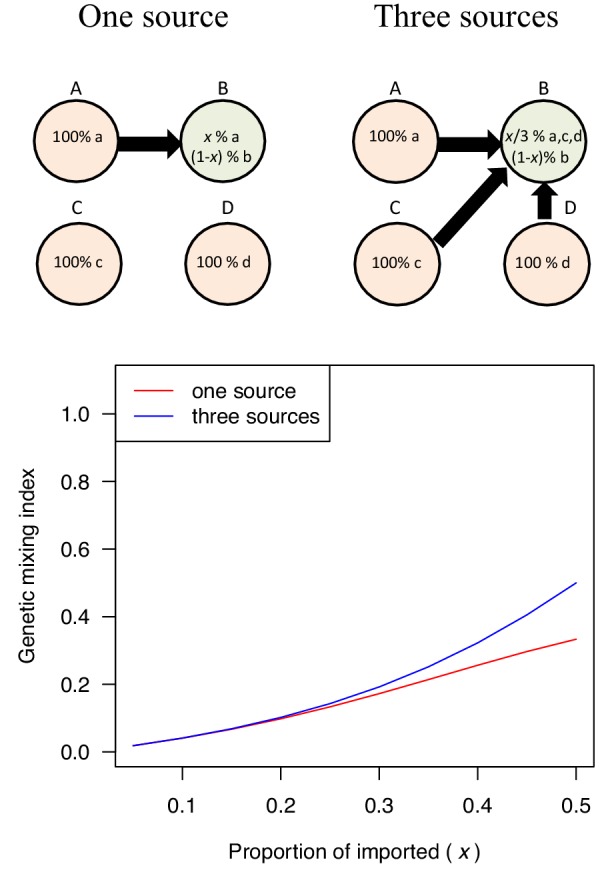
Examples of genetic mixing index.We constructed simplified genetic models in order to provide intuitive interpretation for the genetic mixing index. In the simplified genetic model, we assumed that each location had its own genetic lineage (a, b, c, or d) and migration introduced genetic lineage from one location to the other (x). The model results indicate that the genetic mixing index of population B increased with the proportion of imported cases and the number of source populations.